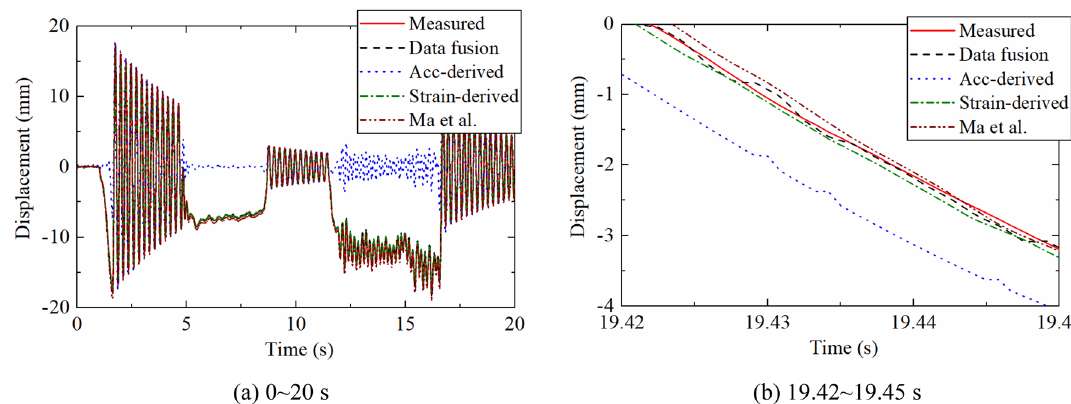
Figure 13. Comparison of displacement reconstructed by different